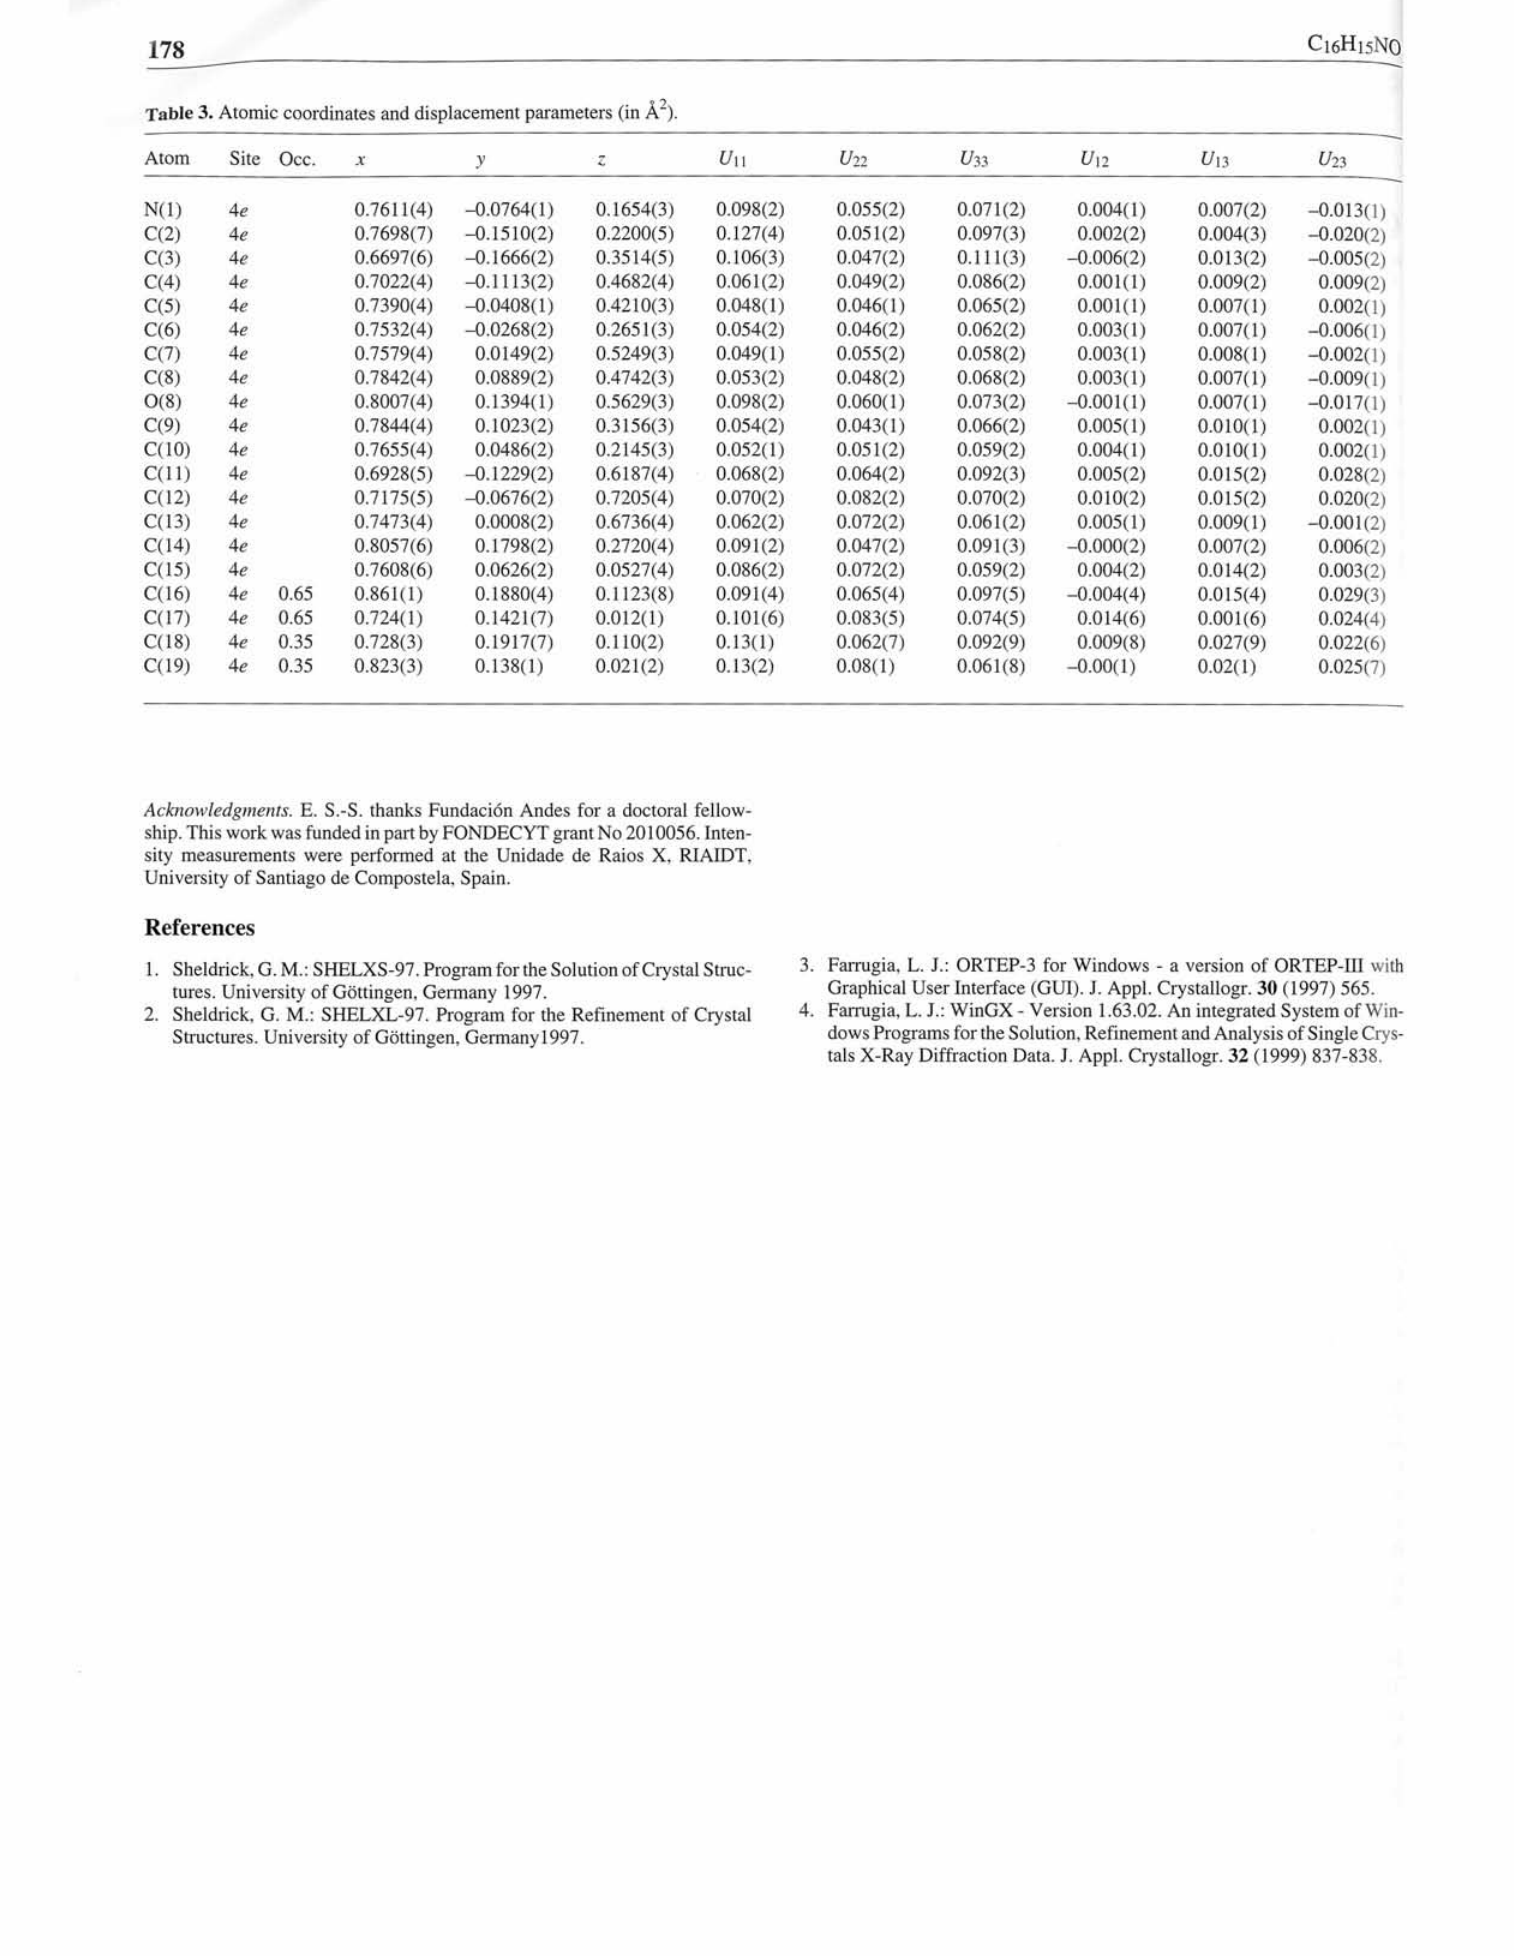
Table 3. Atomic coordinates and displacement parameters (in Á 2